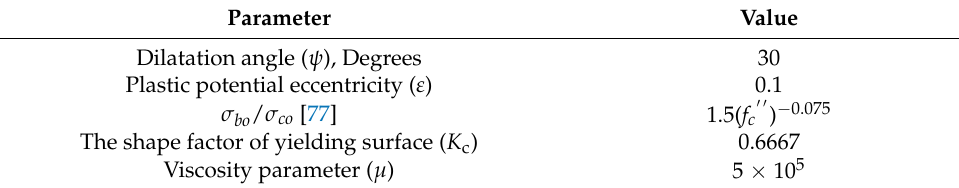
Parameter Value